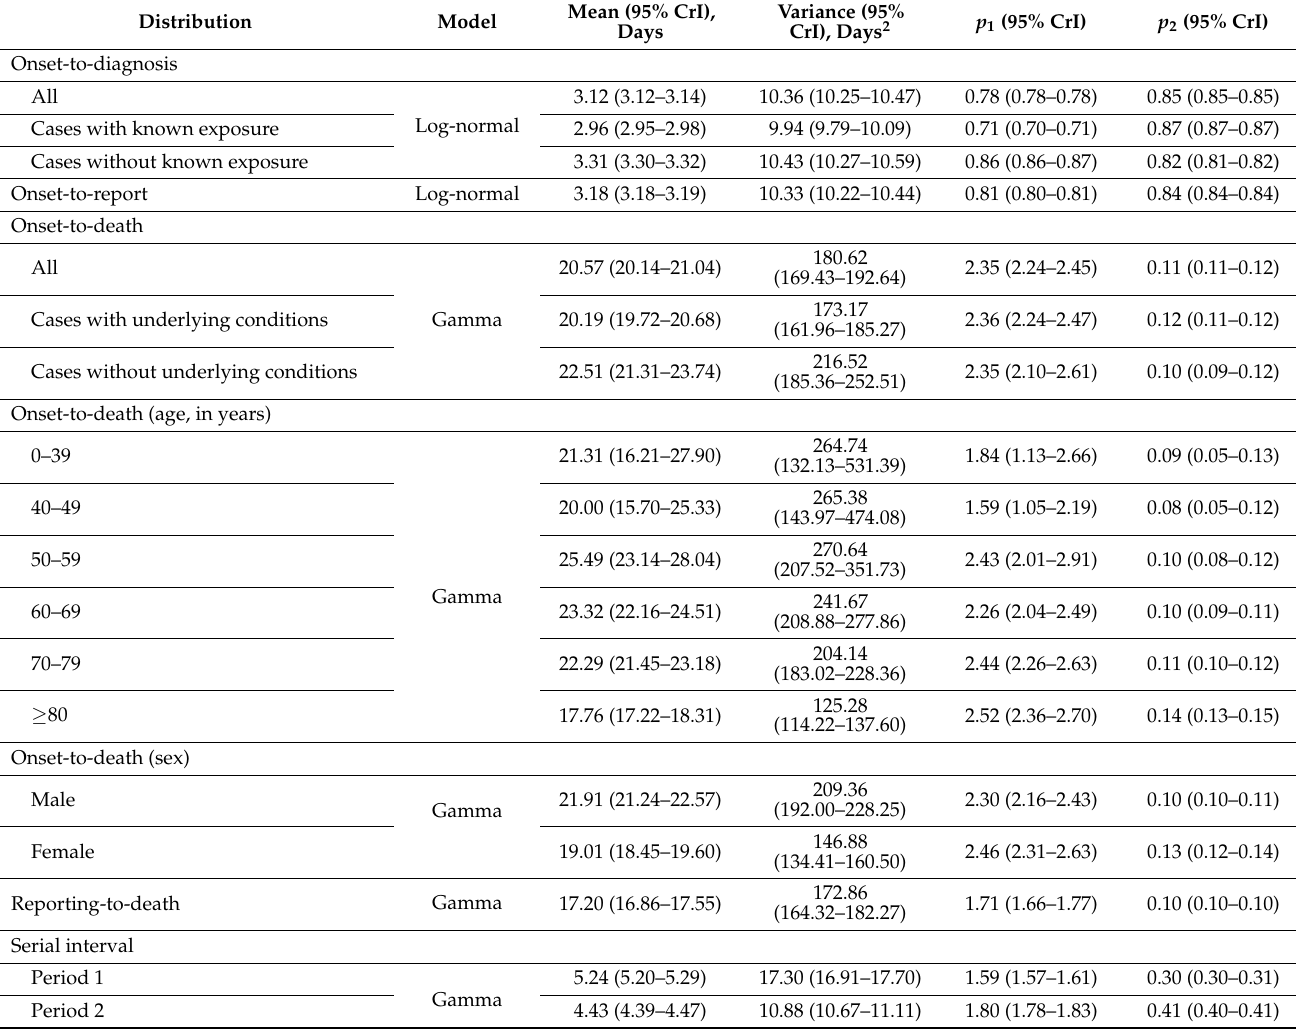
Table 3. Preferred PDFs with the largest Bayesian support for each COVID-19 distribution, with the estimated mean, variance, and other parameters of the